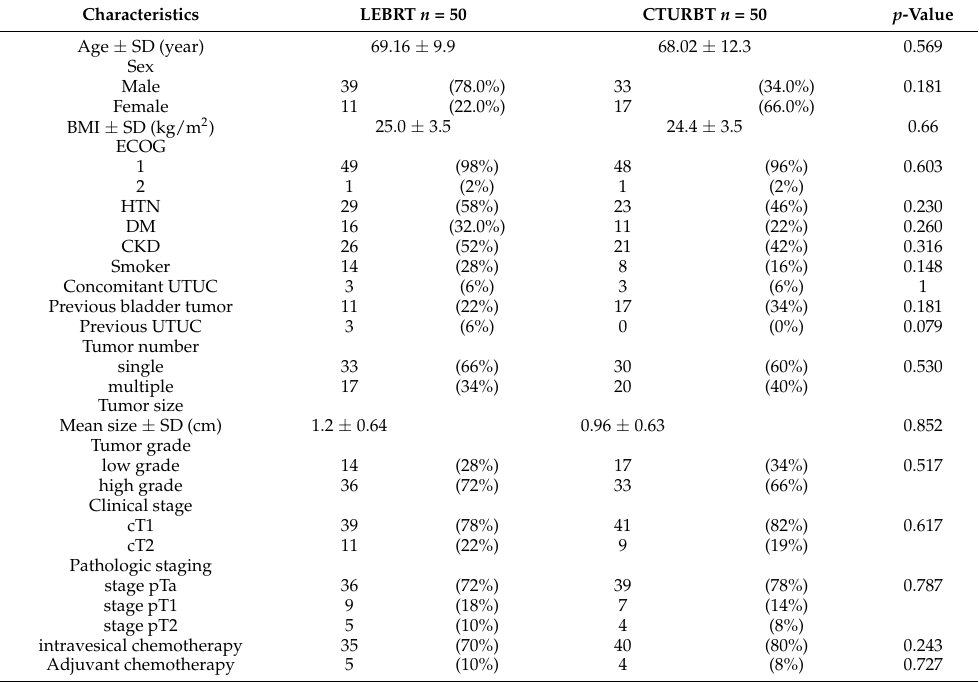
Table 1. Clinico-pathological characteristics between LEBRT and